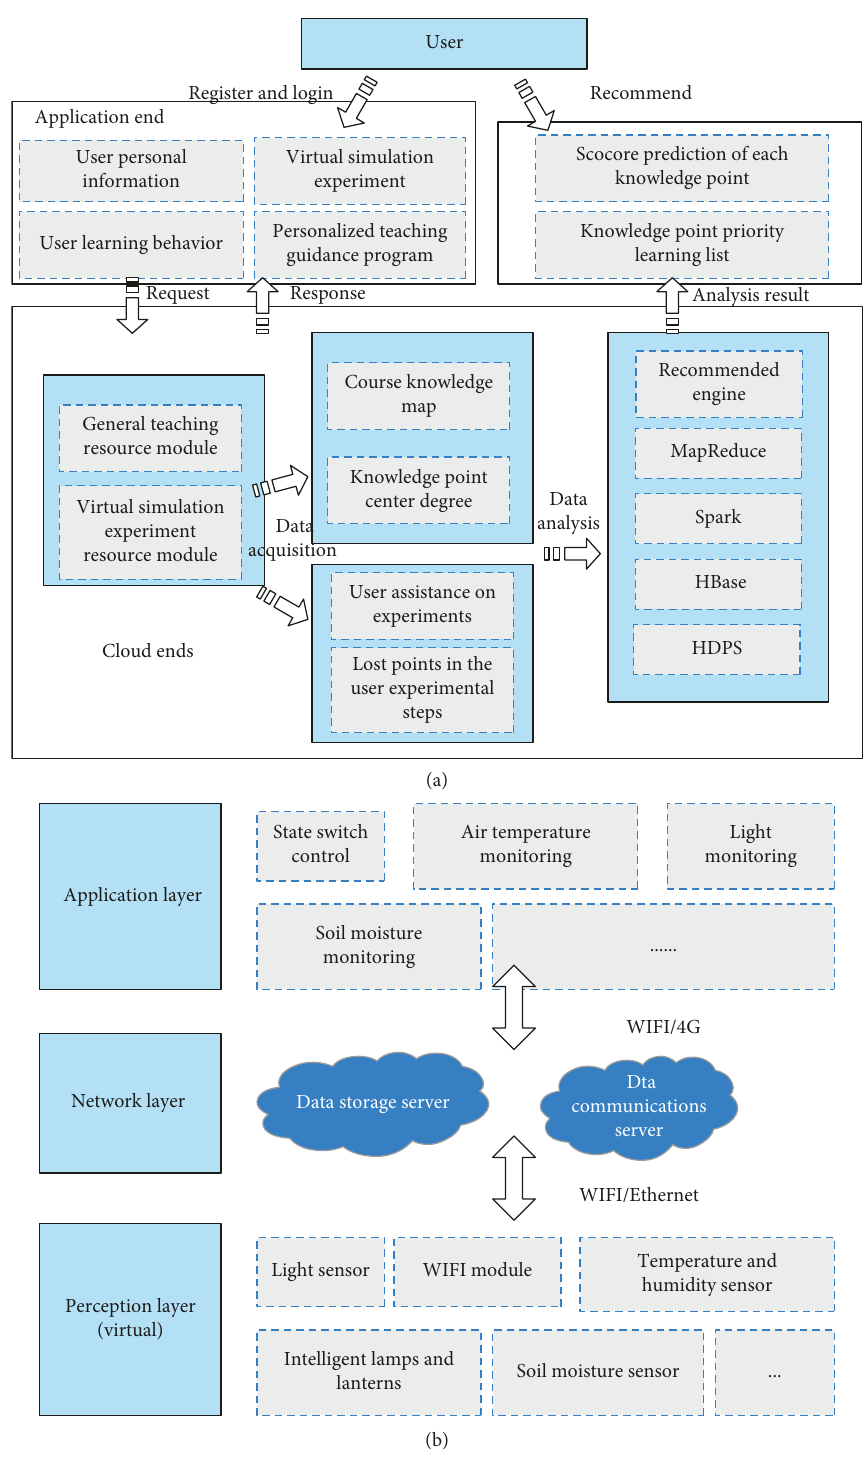
Figure 6: Implementation of system function modules. (a) Implementation of the basic architecture of the system. (b) Foreign language teaching module structure (taking the Internet of Things experiment as an